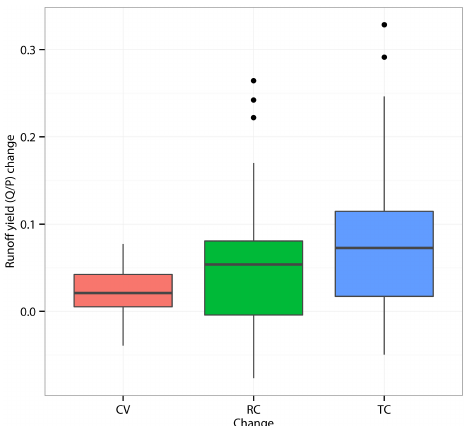
Figure 3. Boxplot of total change (TC), residual change (RC) and change due to climate variability (CV) for the 42 studied catch- ments. For each catchment, RC = TC-CV.